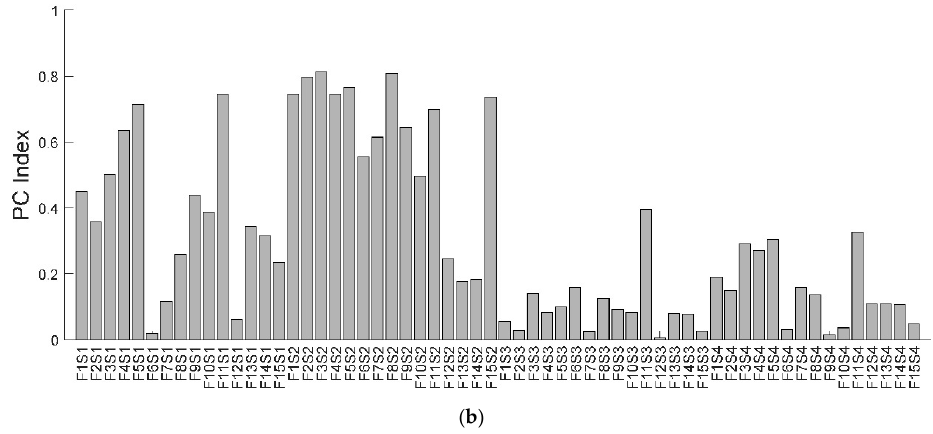
Figure 4. PC index values for each feature (F1 to F15), for each statistic (S1 to S4, respectively, mean, Figure 4. 𝑃𝐶 index values for each feature (F1 to F15), for each statistic (S1 to S4, variance, skewness and kurtosis) and for terrain ( a ) and slippage ( b ) respectively, mean, variance, skewness and kurtosis) and for terrain ( a ) and slippage ( b ) classifier.